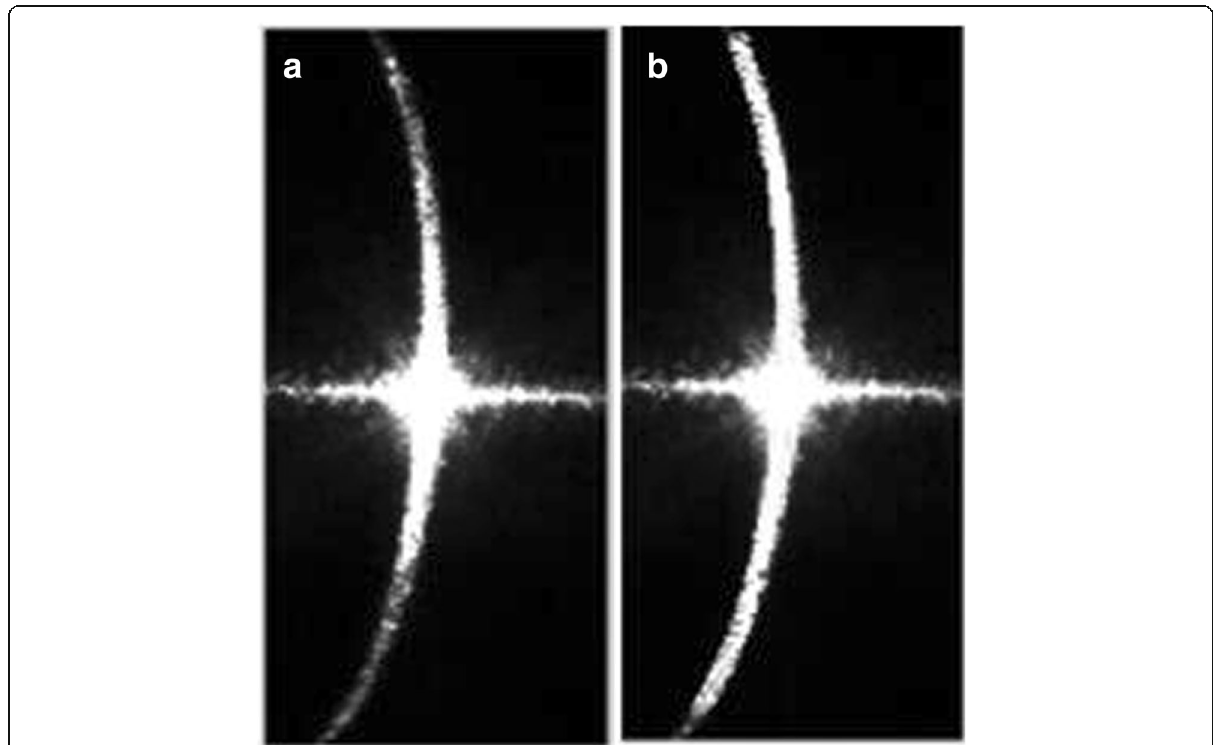
Fig. 10 Comparison of light stripe images before and after optimization (cylindrical surface). a light stripe image before enhancement b The light stripe image after enhancement